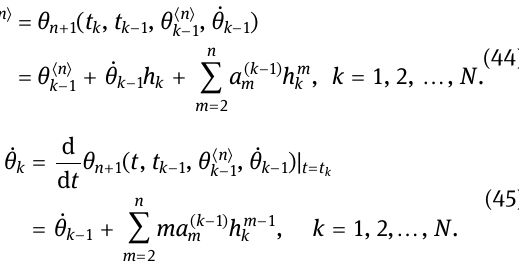
25 ⟨ ⟩ with step - size k